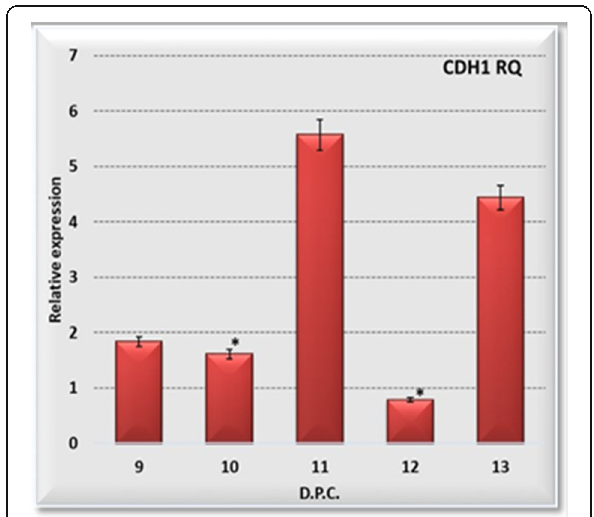
Fig. 1 Histogram representing the gene expression of Alkaline phosphatase (ALP), at the embryonic stages E9.5 to E13.5 of rat embryos ( Rattus norvegicus ).* means significant against 9 D.P.C. group. P < 0.05